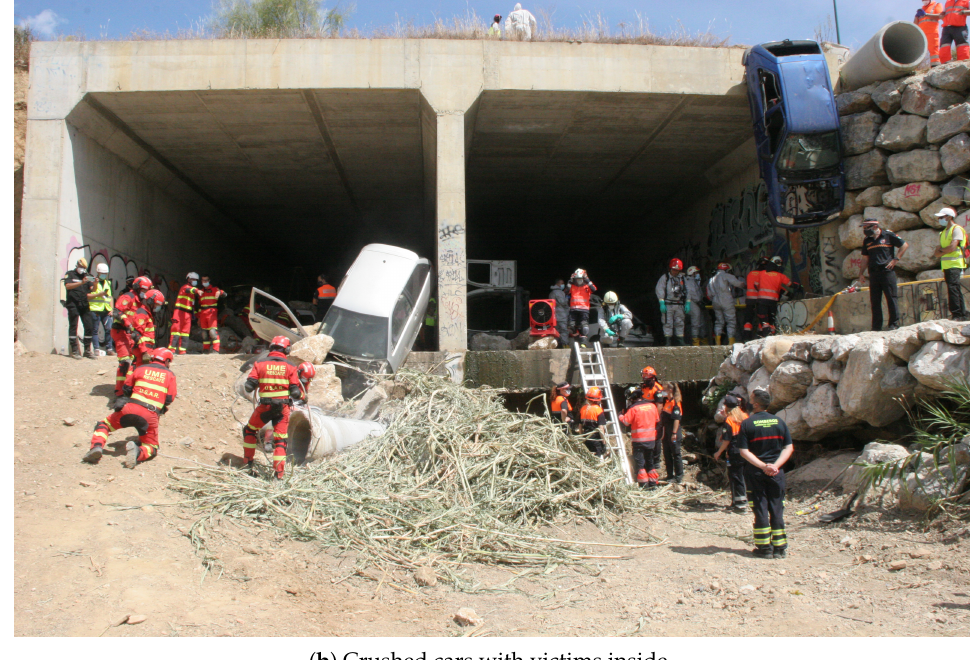
Figure 8. Firefighters and military emergency unit (UME) assissting